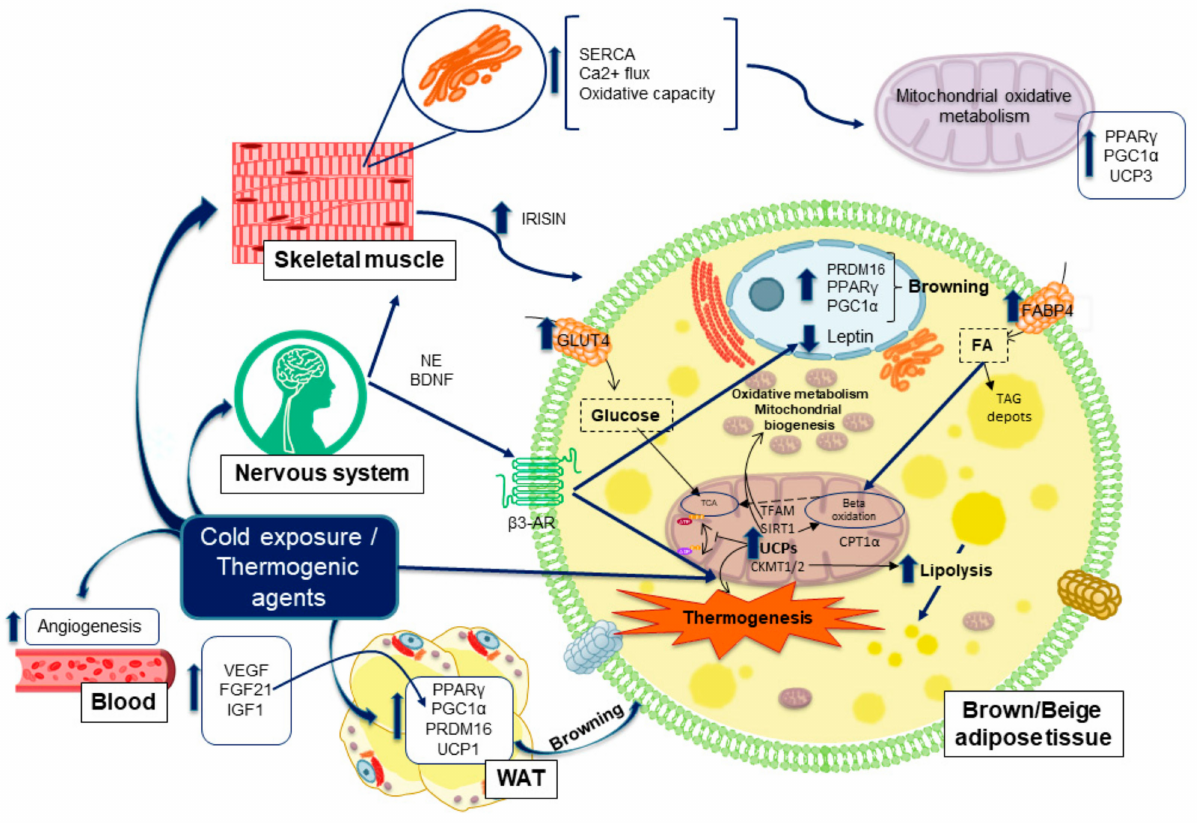
Figure 5. Activation of BAT thermogenesis and WAT browning upon cold exposure: role of the